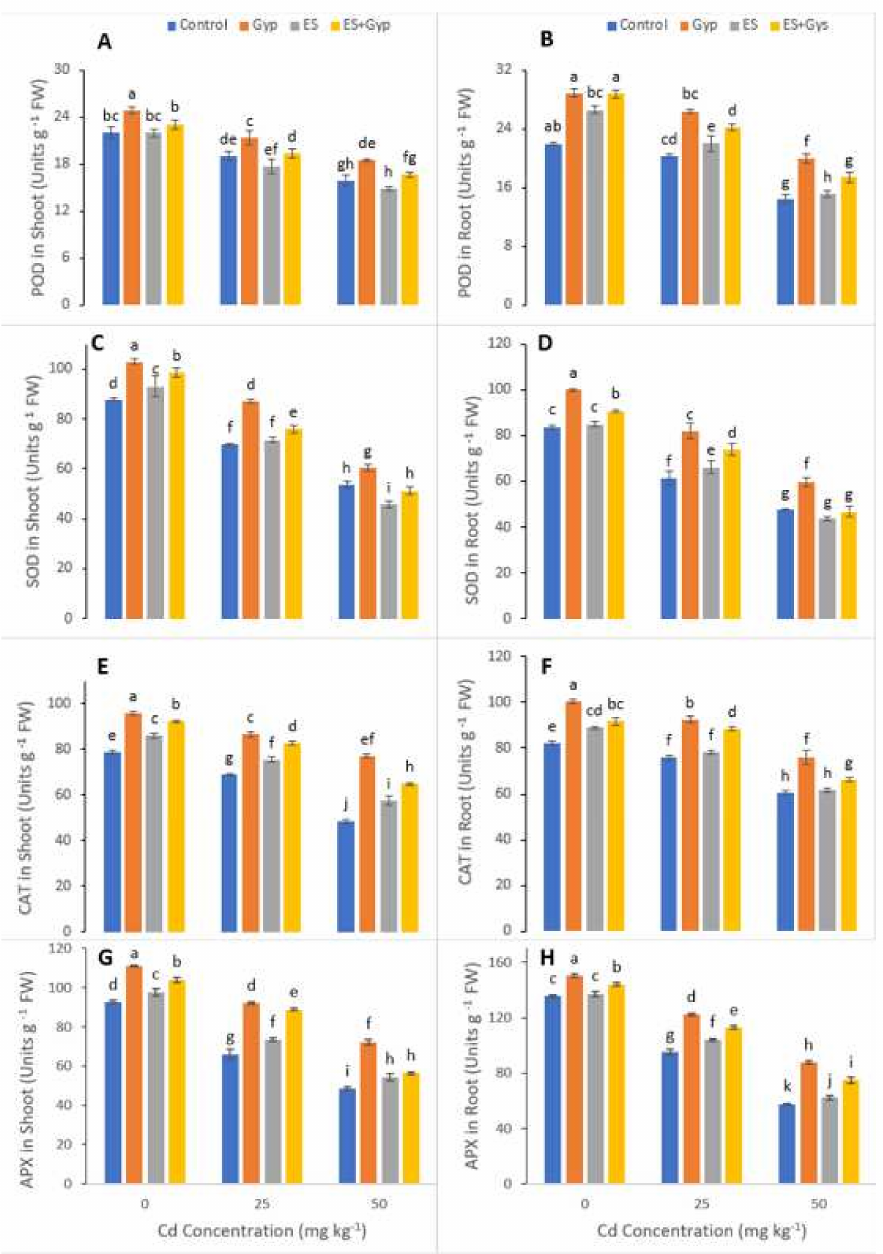
Figure 5. Effect of different concentrations of Cd (25, 50 mg kg − 1 ) in the soil on antioxidant capacity i.e., peroxide activity in the shoots ( A ), peroxide activity in the roots ( B ), superoxidase activity in the shoots ( C ), superoxidase activity in the roots ( D ), catalase activity in the shoots ( E ) catalase activity in the roots ( F ), ascorbate peroxidase activity in the shoots ( G ) and ascorbate peroxidase in the roots ( H ) of S. nigrum grown under the S-Fertilizers, alone GYP, ES and in combination GYP+ES . S-Fertilizer showed significant increase in growth parameters compared to control. Bars sharing different letter(s) for each parameter are significantly different from each other according to Duncan’s multiple range test ( p < 0.05). All the data represented are the average of four